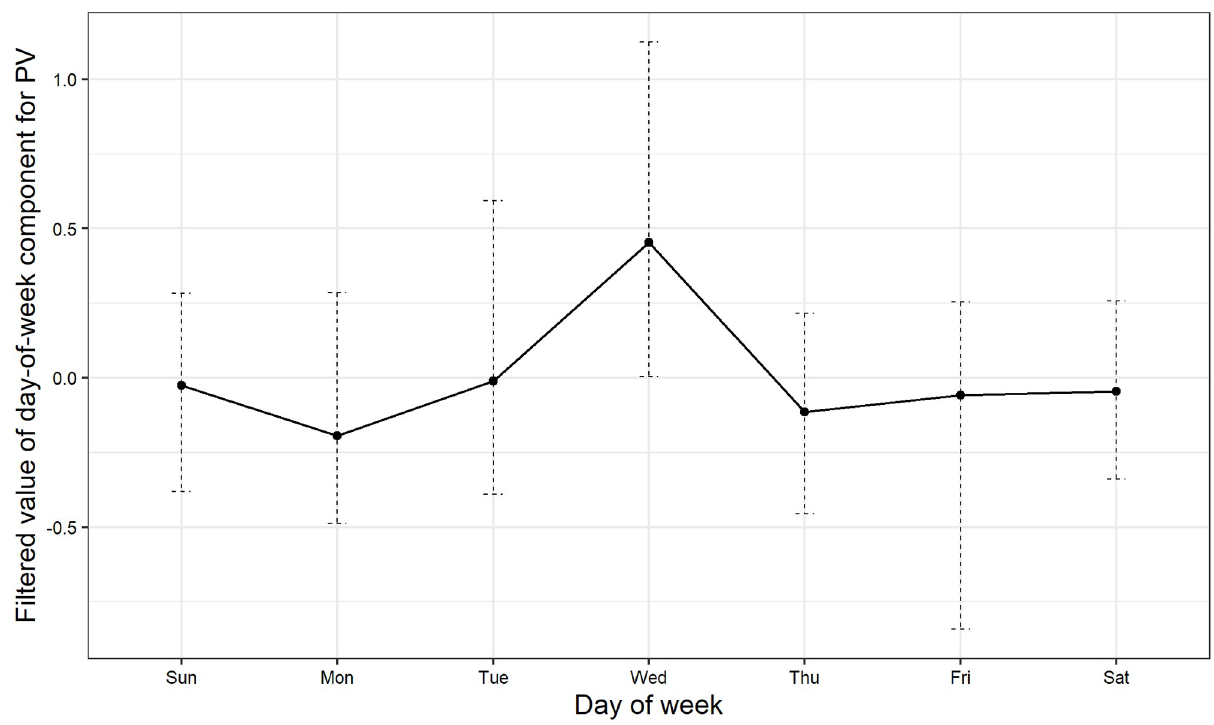
Fig 12. Filtered value of day-of-week